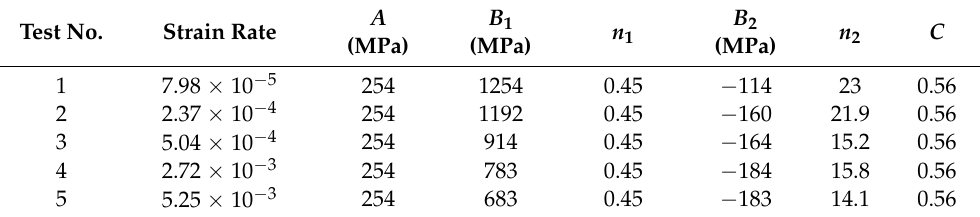
Table 3. Modified model parameters for biaxially tensile condition at RD. Test No.